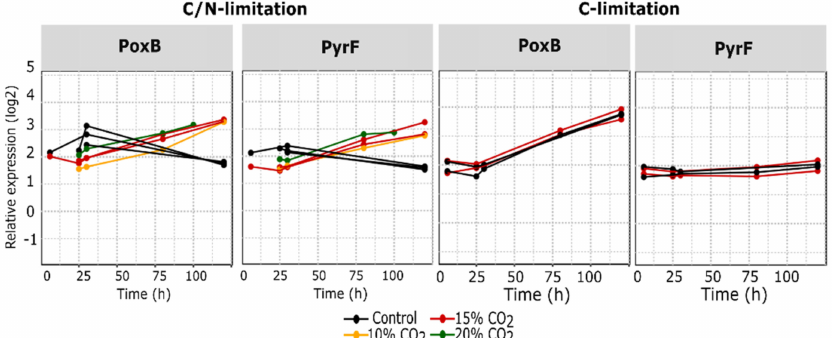
Figure 10. Changes in expression level of selected proteins involved in carboxylation and decarboxy- lation reactions. Y -axis = relative expression in log 2 , X -axis = fermentation age after feed start in hours. Ppc: Phosphoenolpyruvate carboxylase, PyrF: Orotidine 5 (cid:48) -phosphate decarboxylase, PoxB: Pyruvate